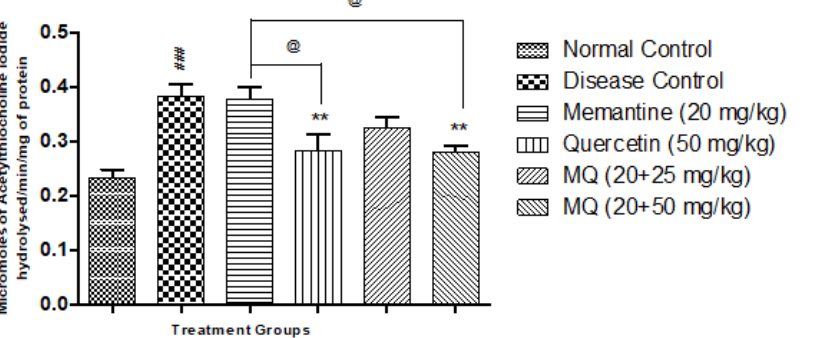
Figure 5. Effect of quercetin and quercetin with memantine on acetylcholine esterase (AChE) in cortex tissue in AlCl 3 -induced neurotoxicity in rats. Data expressed as mean ± SEM (n = 6), ### p < 0.001 when compared with the normal control group, ** p < 0.01 when compared with the disease control group, and @ p < 0.05 when compared with the memantine-treatment group. AlCl 3 , aluminum chloride; SEM, standard error of mean.